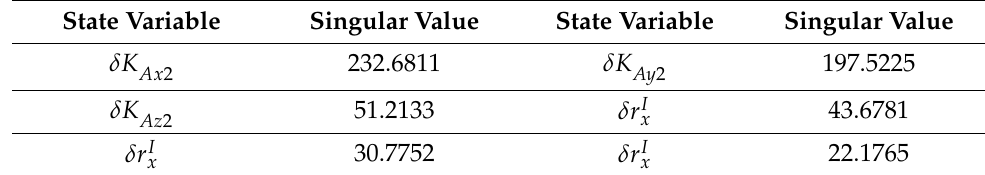
Table 3. The observability degree of each